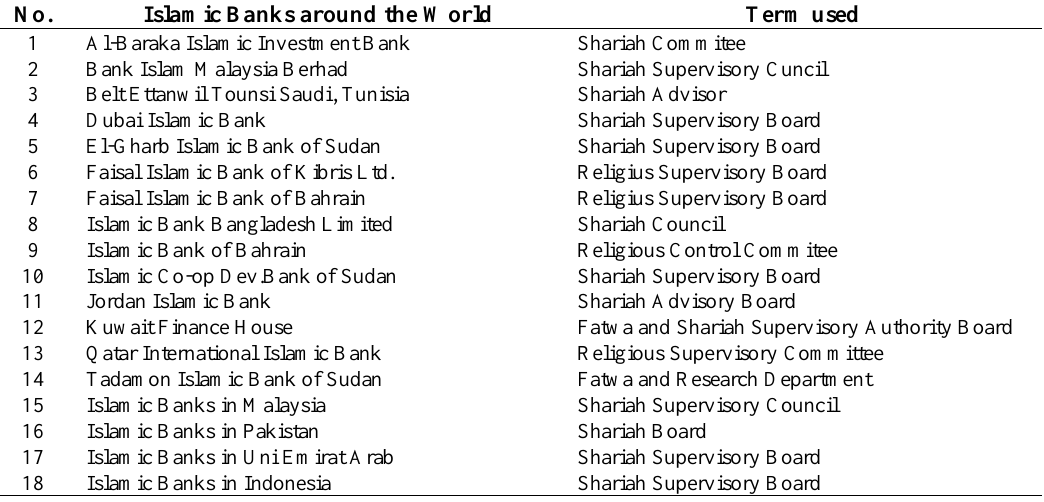
Table 1. Term used of Shariah Supervisory Board in Islamic Bank around the world No. Islamic Banks around the World Term